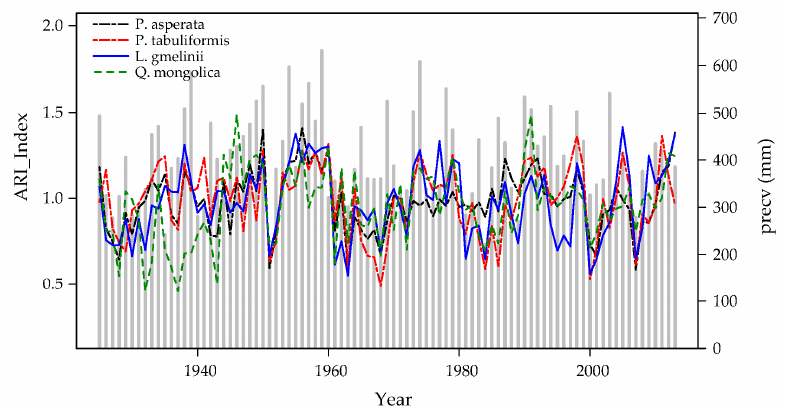
Figure 1. Detrended annual radial increment chronologies (ARI_Index, coloured curves) of P. asperata (black), P. tabuliformis (red), L. gmelinii (blue), Q. mongolica (green) and precipitation sum during the vegetation period (precv, grey bars) covering the 1925 to 2013 time span.